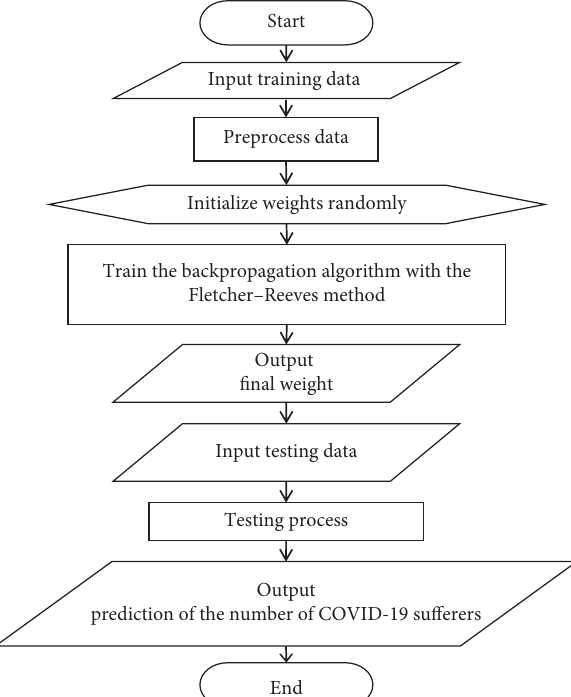
Figure 1: The flowchart of the system for predicting the number of COVID-19 sufferers with the Backpropagation neural network with the Fletcher–Reeves method.